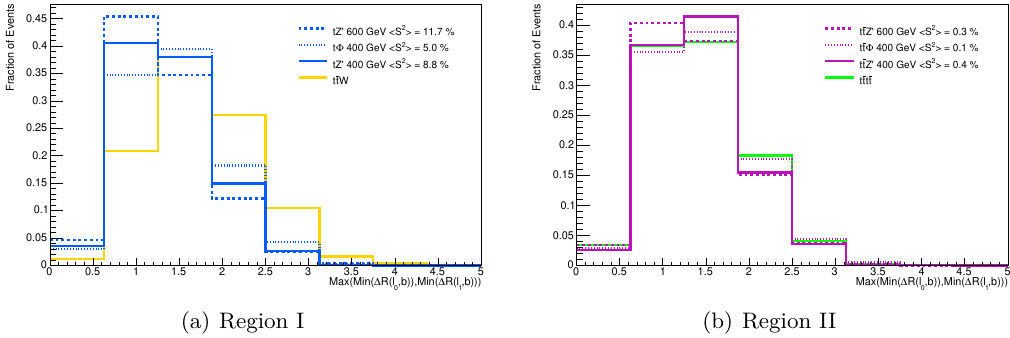
Figure 14 . Fraction of events of the MaxMin ( ‘, b ) observable. We find this observable to be useful for region I which is dominated by tZ 0 / Φ and t ¯ tW , since the latter has a lepton coming from a prompt W